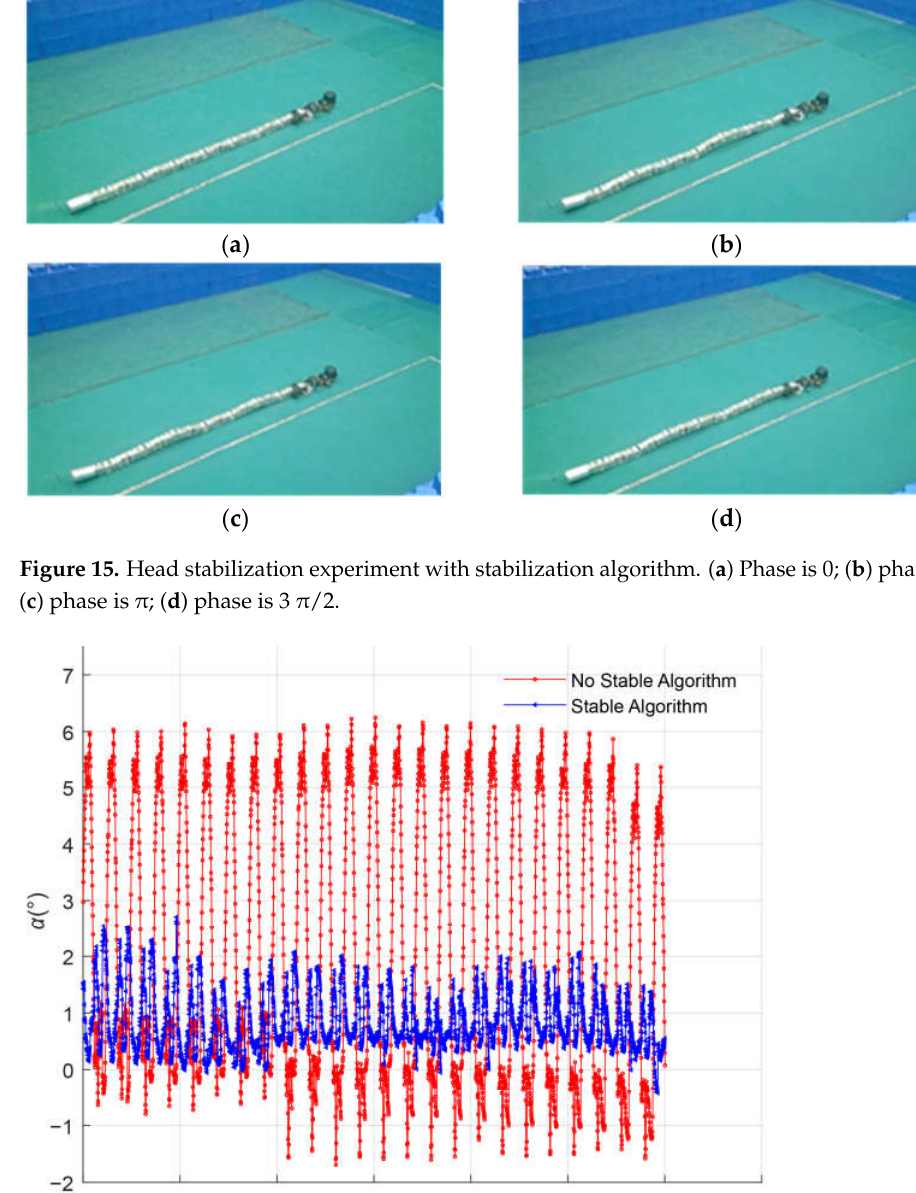
Figure 14. Head stabilization experiment without stabilization algorithm. ( a ) Phase is 0; ( b ) phase is π/2; ( c ) phase is π; ( d ) phase is 3 π/2.